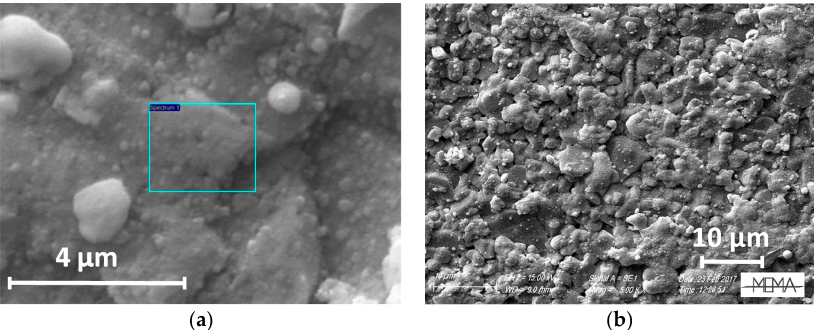
Figure 9. SEM images of a thin In 2 O 3 film as deposited on the gas-sensor device with the LPED technique ( a , b : different magnifications).